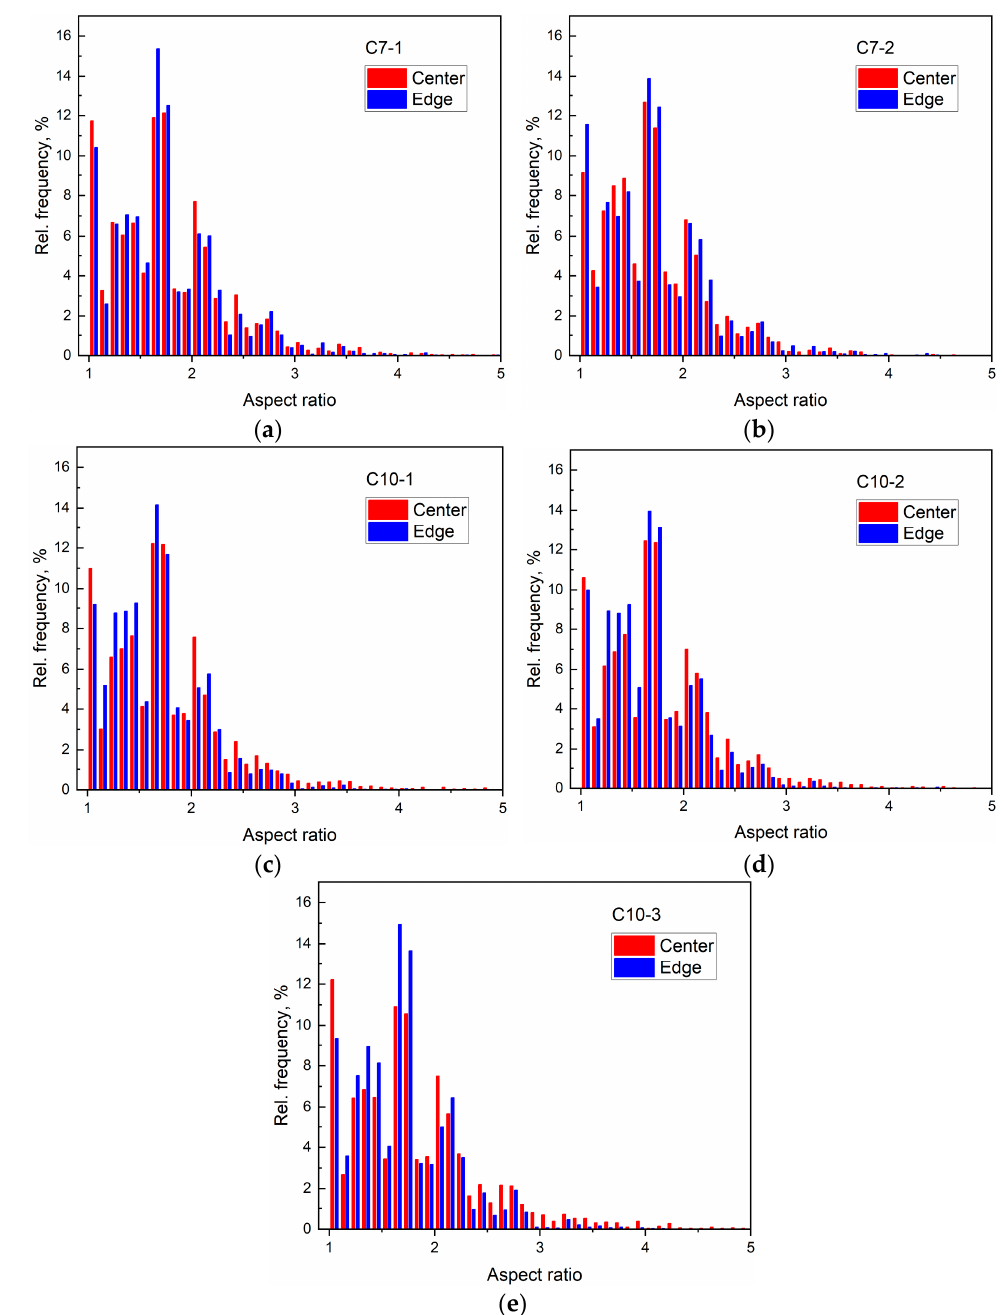
Figure 10. Histograms of the distribution of the aspect ratios of grains in the region of the center and edge of samples ( a ) C7-1 (near the region of destruction of the wire C7), ( b ) C7-2 (far from the region of destruction), ( c ) C10-1 (from the region of the C10 wire near the 1st clamp), ( d ) C10-2 (from the region of the center of the C10 wire), and ( e ) C10-3 (from the region of the C10 wire near the 2nd clamp). For better visualization, the histograms are shifted along the abscissa axis by the width of the base of the histogram columns to the left and right relative to the true position.